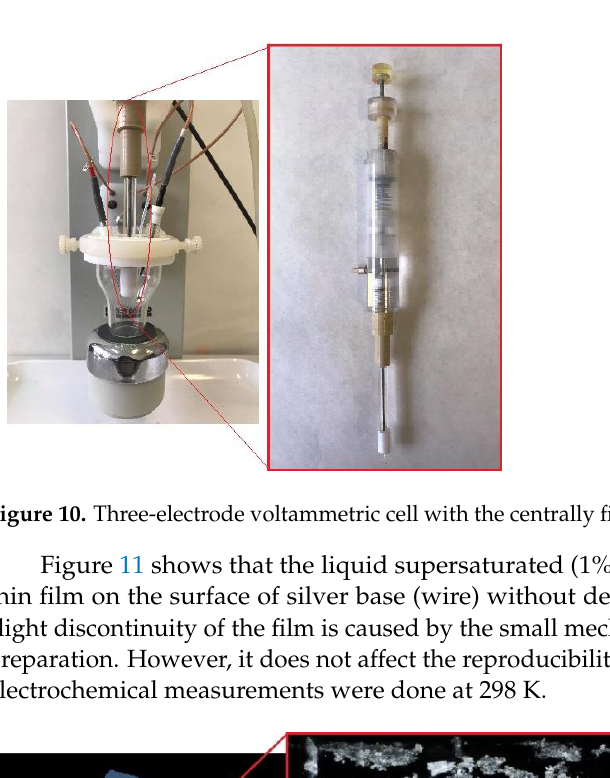
Figure 11. R–AgLAFE surface seen as an image from a Nikon Eclipse MA200 optical microscope with a “Nikon Lu Plan Fluor 10x/0.30A” objective.